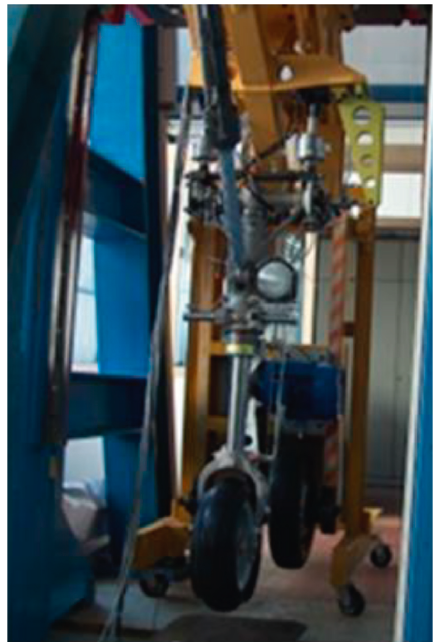
Figure 2: Laboratory for experimental drop